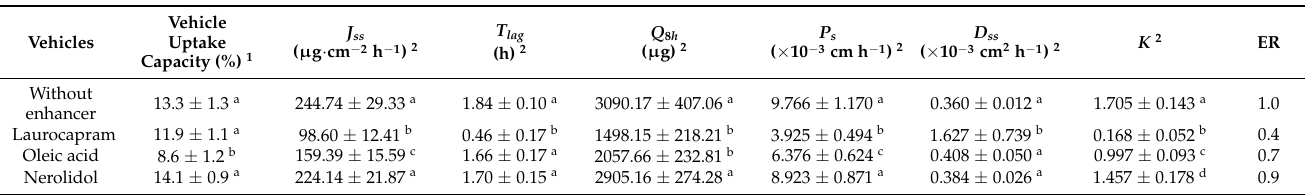
Table 5. Effect of combined enhancers on vehicle uptake capacity of mucosa and ex vivo permeation parameters of CBD with PG:DEGEE system.